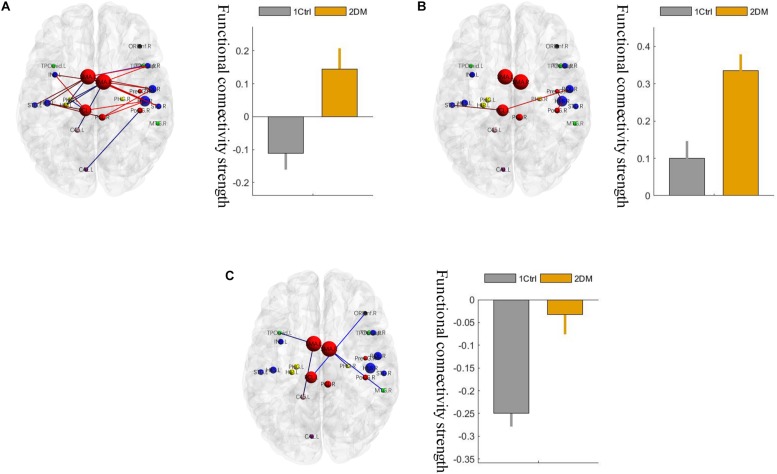
Three different changed patterns of the 33 functional connectivities. (A) Pathological between-network positive connectivities. Different colors represent connectivities between different networks; the red links represent the connections between the sensorimotor network and the auditory network; the blue links represent the connections that are not between the sensorimotor network and the auditory network. (B) Hyperconnectivity: the red links represent enhancement of positive connectivity. (C) Hypoconnectivity: the red links represent reduction of negative connectivity. The error bars in the figures represent the variance. 1 ctrl: the first group is the control group; 2 T2D: the second group is the type 2 diabetes group.